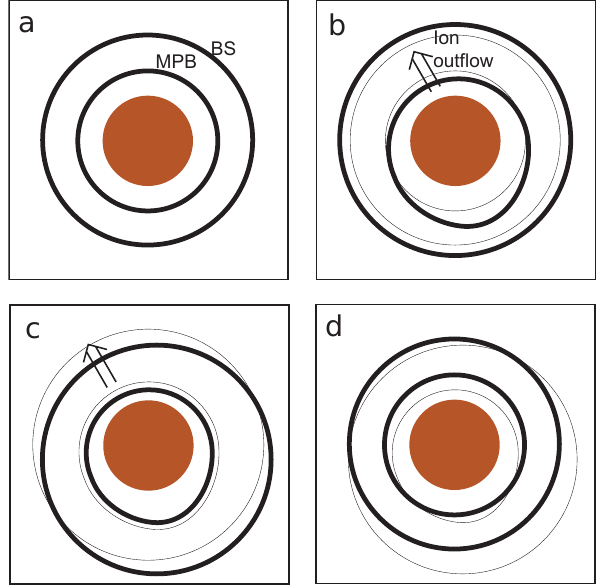
Fig. 6. Sketch of the position of the plasma boundaries in the termi- nator plane as seen from the Sun. In each panel are the boundaries at one specific time in the time history of the boundary positions illustrated. The movement resulting from the encounter of the high pressure solar wind as observed during the last three orbits on 25 February 2007 and when the high pressure solar wind region had passed. The thick black solid lines represent the BS and MPB, while the thin black lines in each panel represent the BS and MPB as they were in the previous panel. The boundaries go from being symmet- ric in panel (a) to asymmetric in panels (b) and (c) when ion outflow is observed, to finally become symmetric again in panel (d) when the high pressure solar wind has